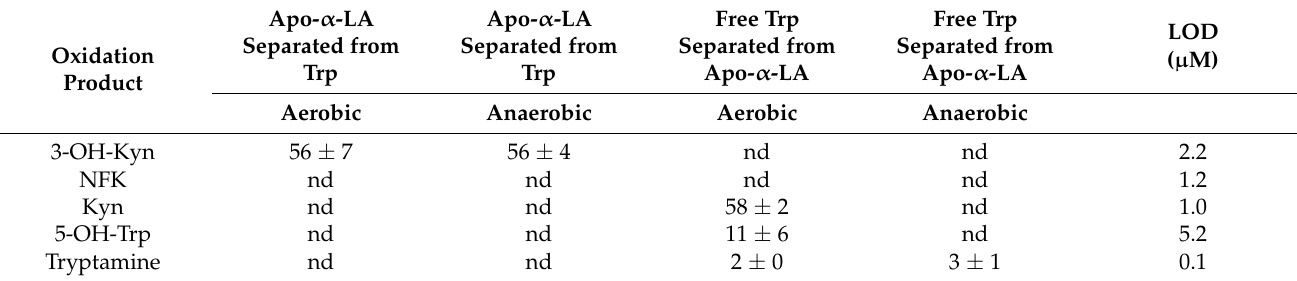
Table 1. Concentration ( µ M) of Trp oxidation products formed in apo- α -LA (0.705 mM) illuminated for 24 h with added Trp (2.8 mM) under aerobic and anaerobic conditions. Free Trp was separated from α -LA by spin filtration, and each of the fractions was analyzed by UHPLC with UV and fluorescence detection. The α -LA samples were subjected to acidic hydrolysis prior to the UHPLC analysis. Results are presented as mean values ± standard deviations obtained from three independent experiments. LOD; limit of